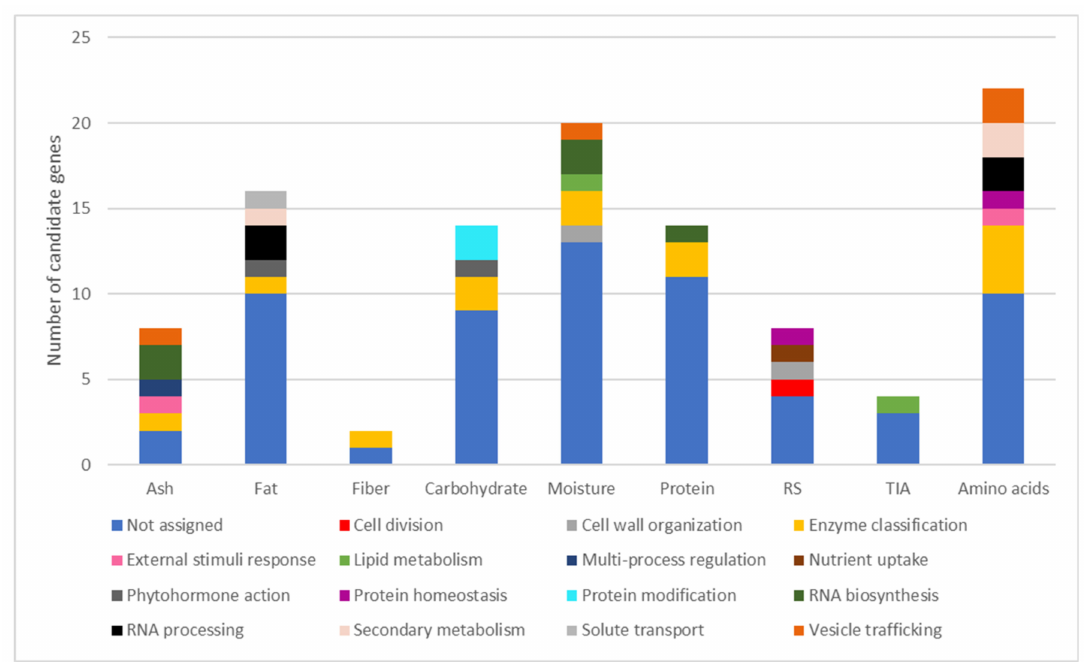
Figure 5. MapMan functional categories of the candidate genes associated with the nutritional composition and protein quality-related traits in 106 Portuguese common bean accessions grown in two contrasting environments. Candidate genes for amino acid contents were pooled together. The nine bar charts represent the number of candidate genes of a given functional category associated with ash, fat, fiber, carbohydrate, moisture, protein, resistant starch (RS), trypsin inhibitor activity (TIA), and amino acid